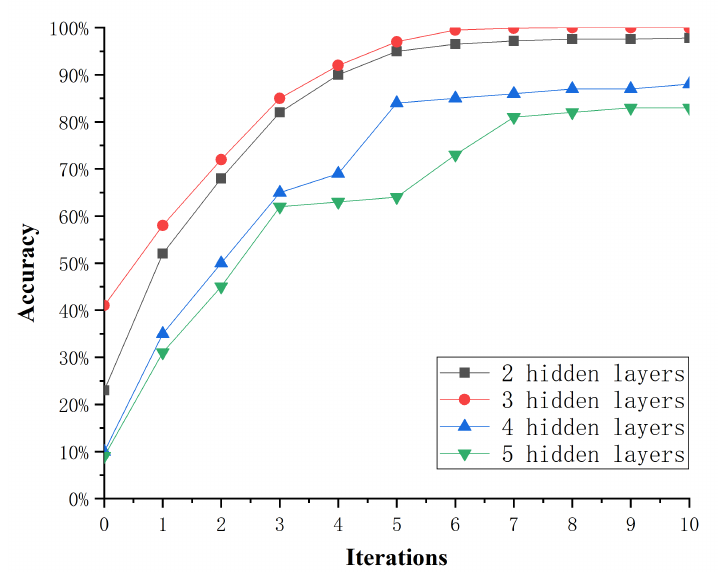
Figure 8. The effect of the hidden layer numbers.